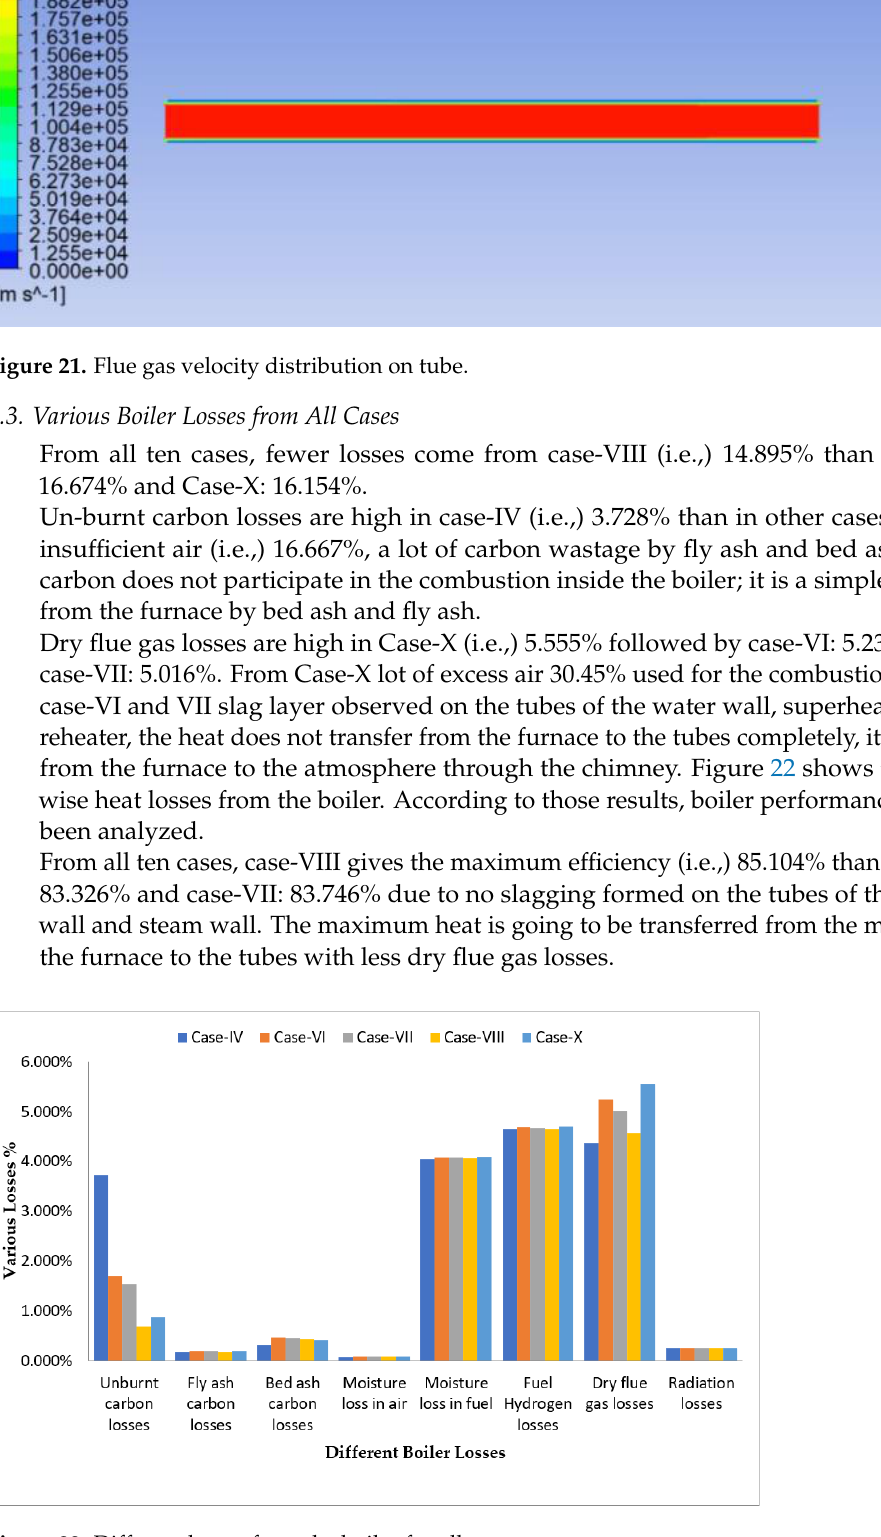
Figure 20. Flue gas temperature distribution on tube.